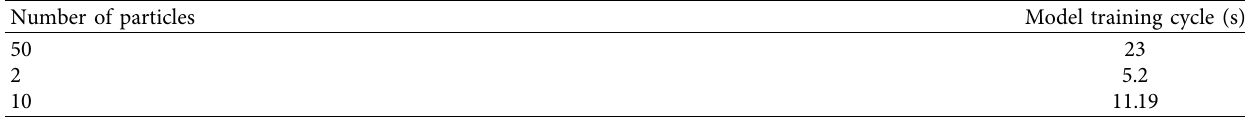
Table 4: Iteration cycle statistics of PSO-ELM algorithm.